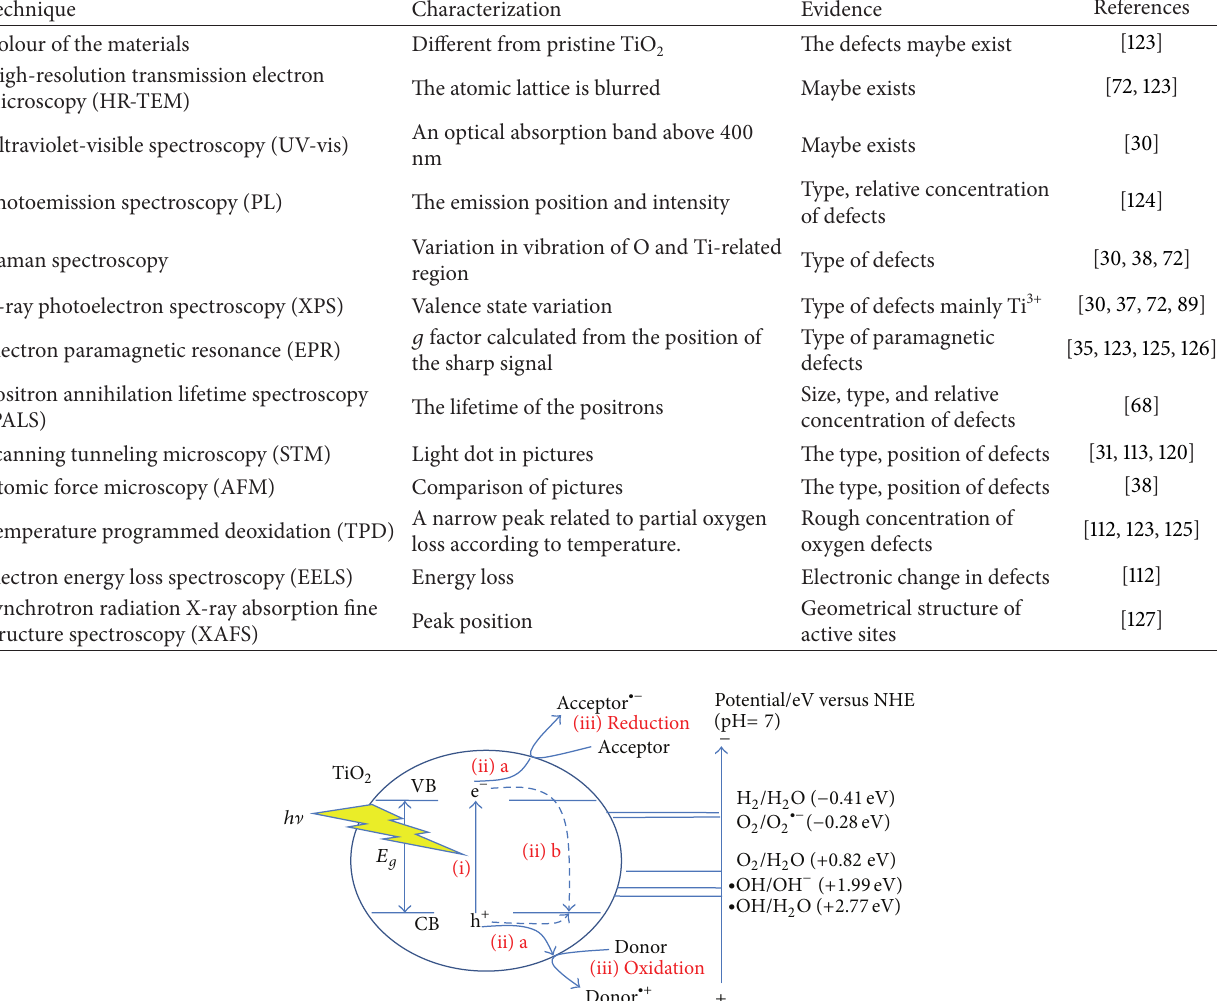
Table 1: Common characterization techniques for defects.